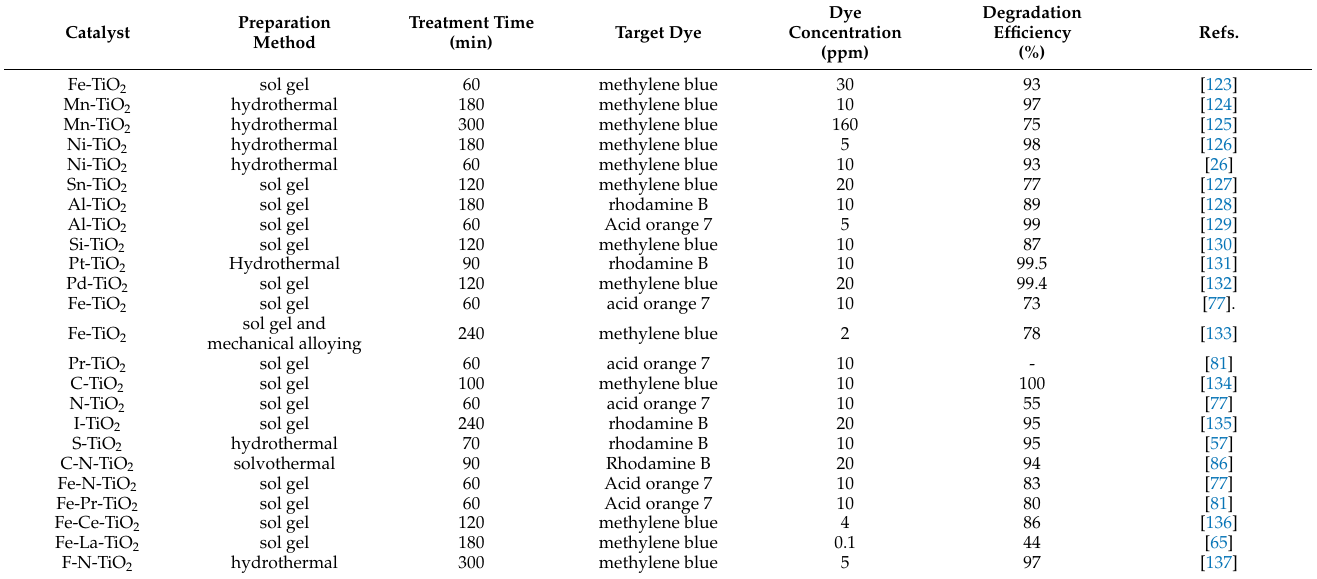
Table 2. List of doped and codoped catalysts used on visible light degradation of dye